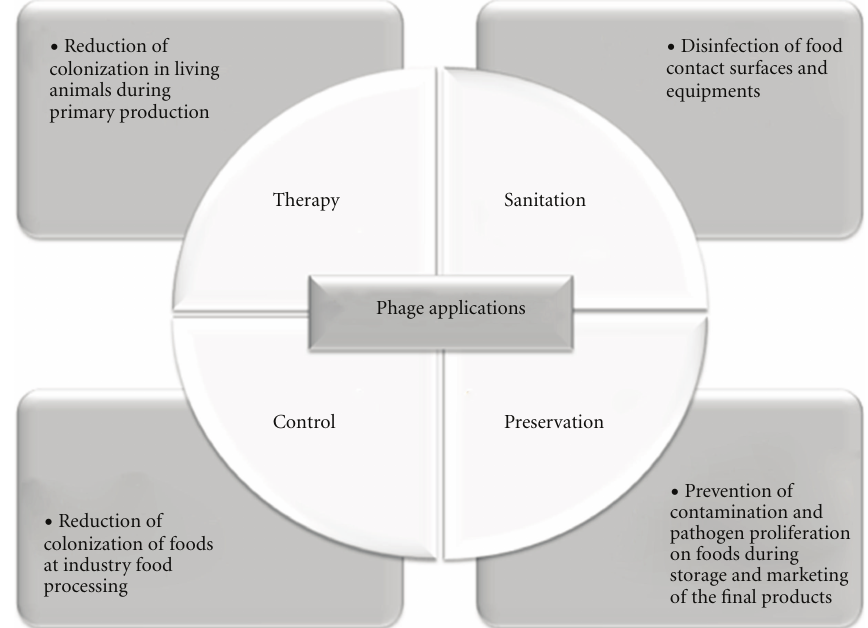
Figure 1: Feasible applications of phages along the food chain towards an increased food safety (adapted from Greer